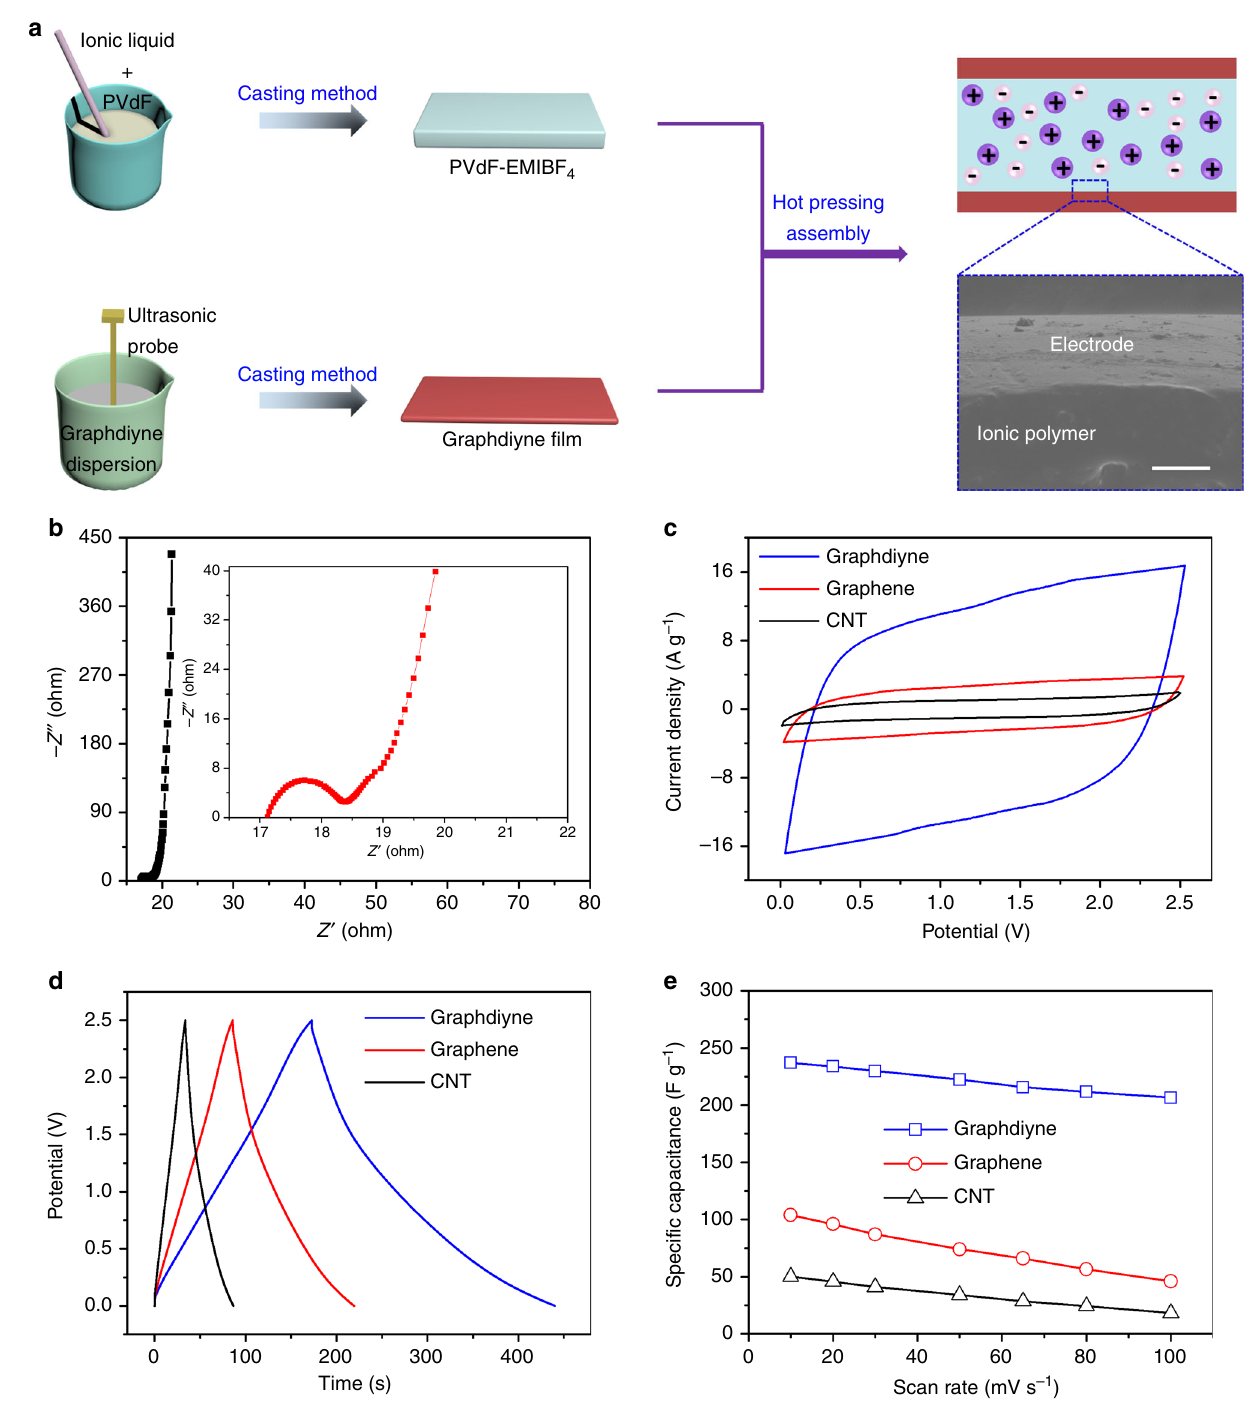
Fig. 2 Assembling and electrochemical properties of the graphdiyne actuator. a Schematic for the assembly procedure of the graphdiyne actuator. Cross- sectional SEM image of the graphdiyne actuator with fi ne interfacial adhesion, scale bar 10 μ m. b Nyquist plot for the device. The inset shows magni fi ed 0 – 22 ohm region. c CV curves of the devices based on graphdiyne, graphene, and CNT at a scan rate of 100 mV s − 1 , respectively. d Charge − discharge curves of graphdiyne, graphene, and CNT actuators at the current density of 1 A g − 1 . e Speci fi c capacitances of actuators as a function of current